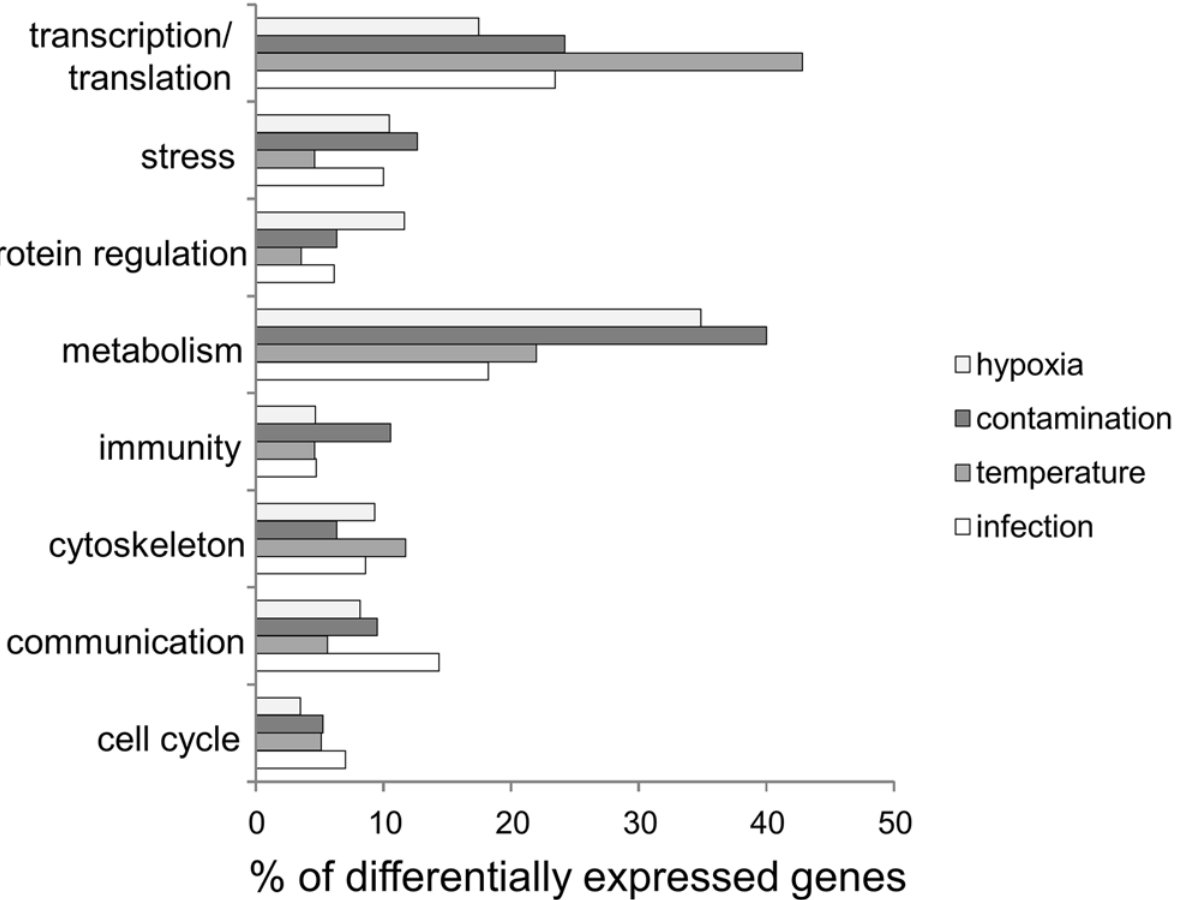
Fig 6. Biological functions of genes that were differentially expressed in response to four general categories of stress: hypoxia (n = 101 genes); contamination (hydrocarbons, metals, and pesticides, n = 115); temperature extremes (high and low, n = 280); and, infection ( Bonamia ostrea, Martelia sydneyi, Perkinsus marinus , generic bacterial sp., Vibrio splendidus , and Ostreid herpes virus 1 , n =